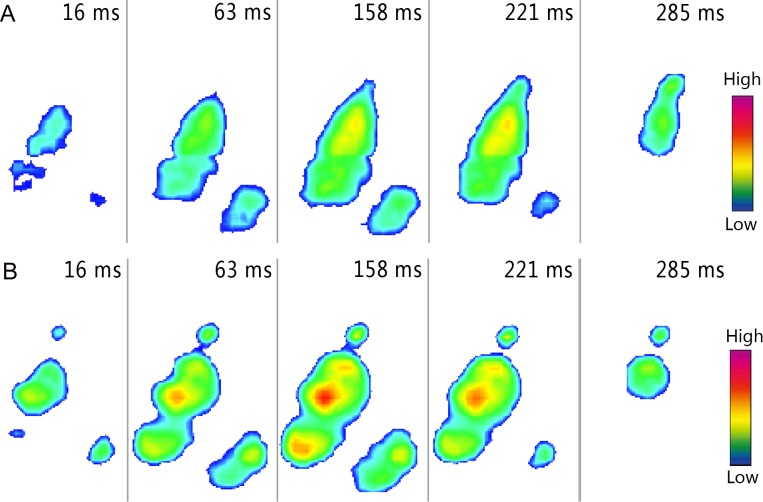
Roll-off patterns of the right toe during loose sand (A) and solid ground (B) running trials.The images were recorded at 16, 63, 158, 221, and 285 ms after touch-down of foot. Loads were indicated on a gradient from red to dark blue (the same below).